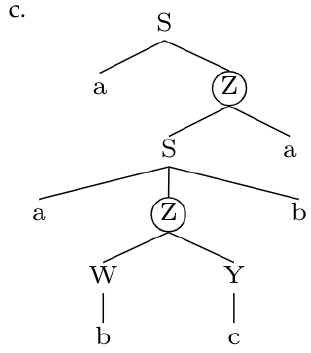
Figure 5. Derived tree.